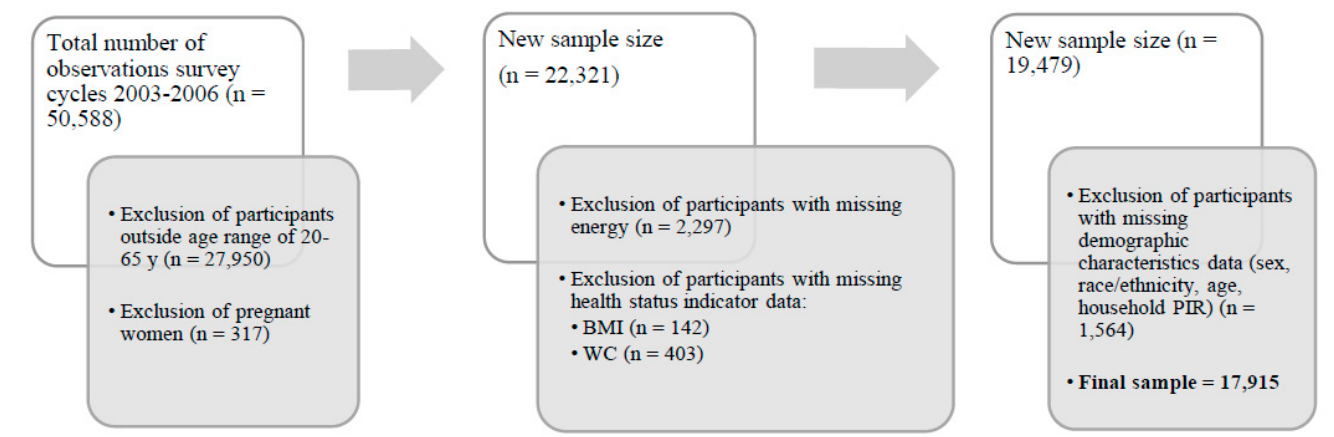
Figure 1. Flow chart representing sample size attrition and reason for exclusion. Final sample is this study sample that meet all the inclusion criteria. WC: waist circumference. BMI: body mass index.